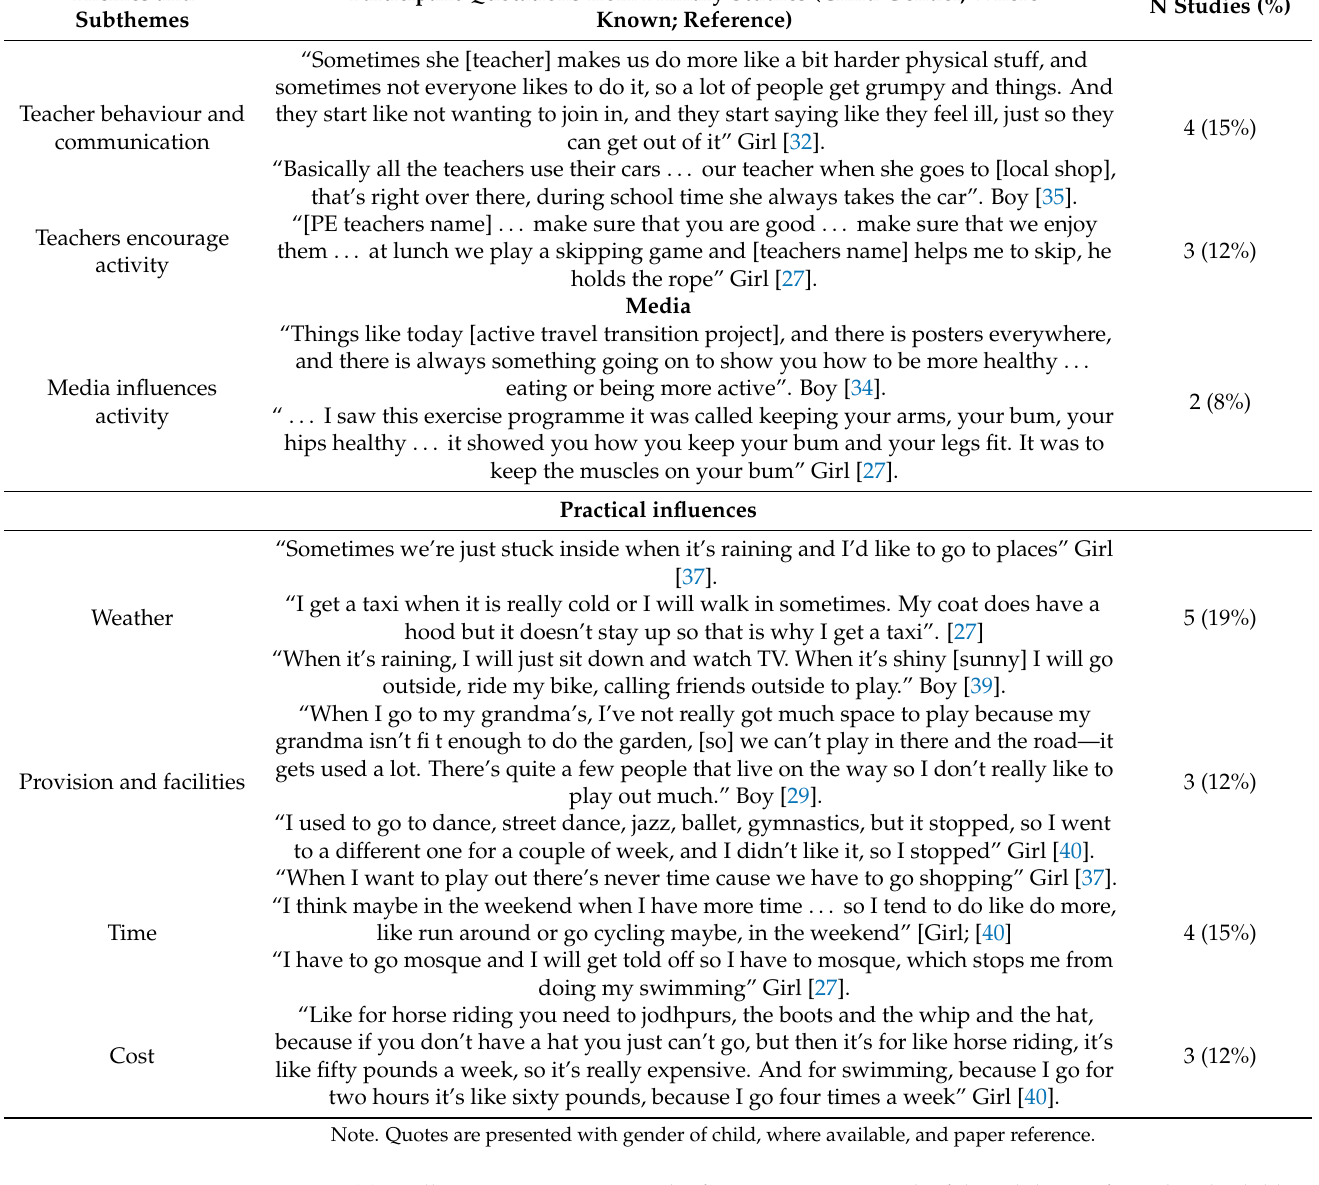
Table 6. Illustrative quotations and references reporting each of the subthemes for ‘What do